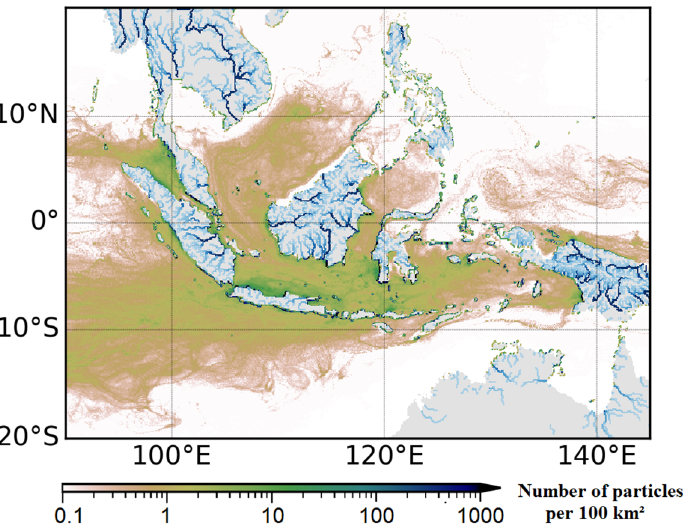
Figure 3. Time average number of simulated particles per 100 km 2 over the last year of simulation (1 of April 2019 to 1 of April 2020).